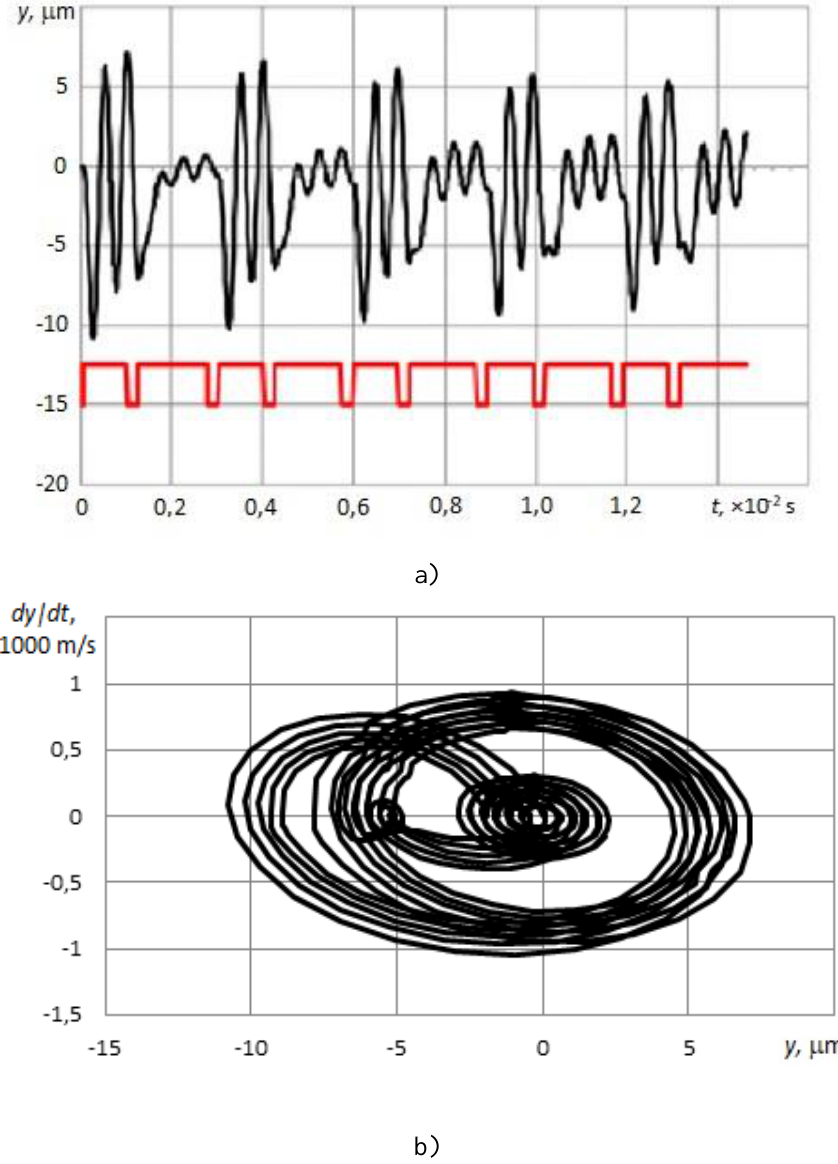
Figure 4. Calculated vibratory displacements at V=80 m/min (a) and phase-plane portrait